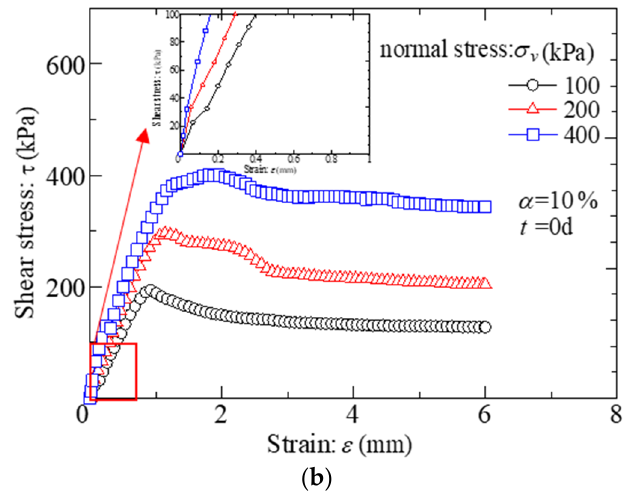
Figure 3. Stress–strain curves of biochar–clay mixtures with methane oxidizing bacteria under various normal stresses: ( a ) α = 0%, t = 0 d. ( b ) α = 10%, t = 0 d.